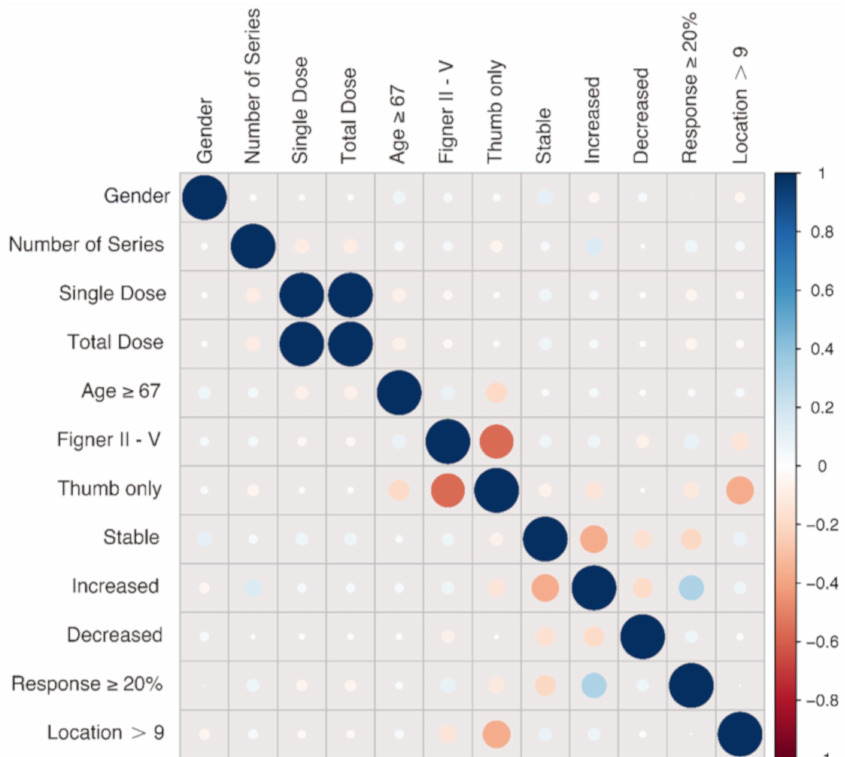
Figure 5. Correlation plot summarizing the analyzed impact factors. The size of the dots states the strength of the correlation while the color reveals a positive (blue) or negative (red) correlation between two factors. The plot visualizes the correlation of all investigated impact factors on treatment